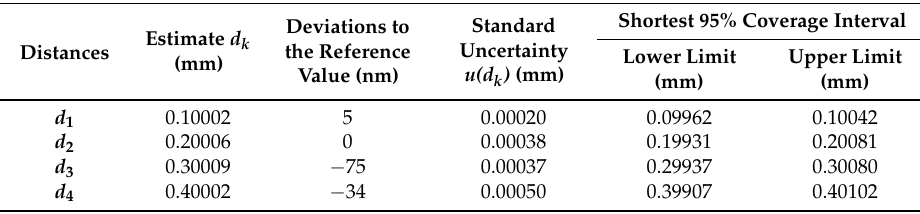
Table 5. Measurement results of the glass line scale in horizontal position. Hypothesis